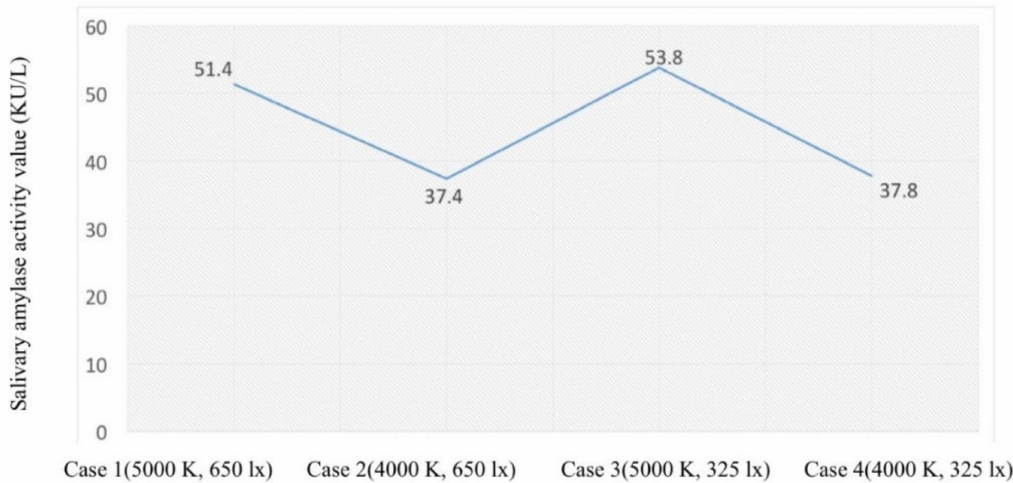
Figure 5. Averages of salivary amylase activity values in di ff erent illumination